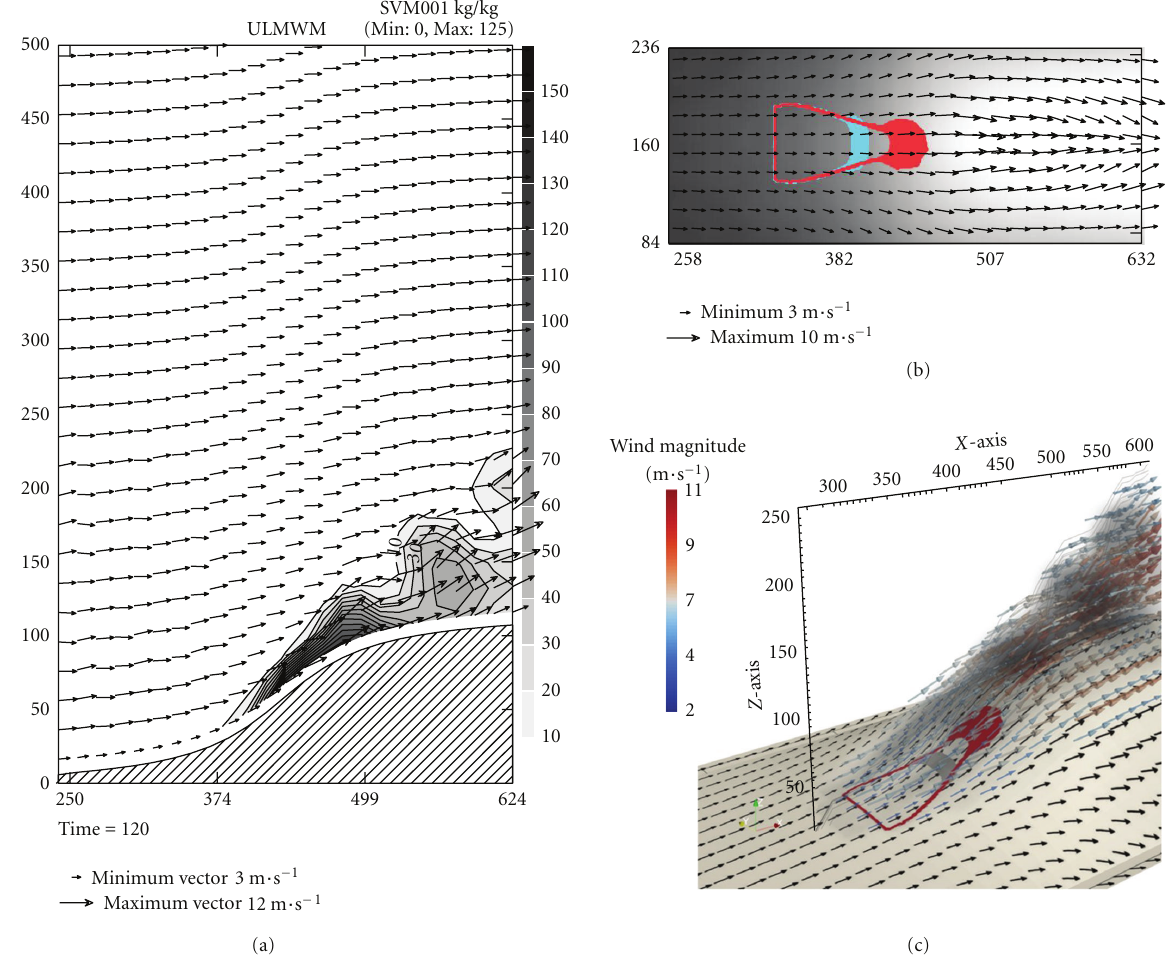
Figure 6: RIDGE (a) Horizontal section ( x/y ) at Z = 10 m, fire lines after 120 seconds for the coupled (red) and noncoupled (grey) simulations. Arrows denote the wind vectors at ground level for the coupledcase. (b) Cross-section ( x/z ) of the coupled case at Y = 160 m, shading represents concentration of the injected passive tracer. (c) 3d wind field and passive tracer concentration isocontours. Table 2: Experimental parameters, with A : Radiant factor, R 0 : rate of spread without wind and slope, r 0 flame thickness speed factor, u 0 : flame gas velocity, R T : fire residence time, Q n : nominal heat flux, Wv n : nominal water vapour, flux and T n : nominal radiant